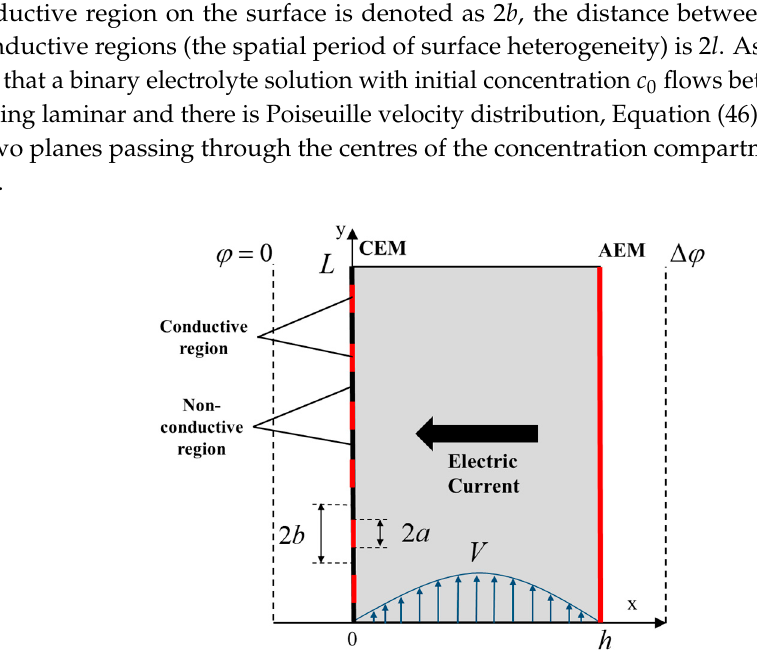
Figure 10. A desalination ED channel formed by a heterogeneous CEM and a homogeneous AEM.